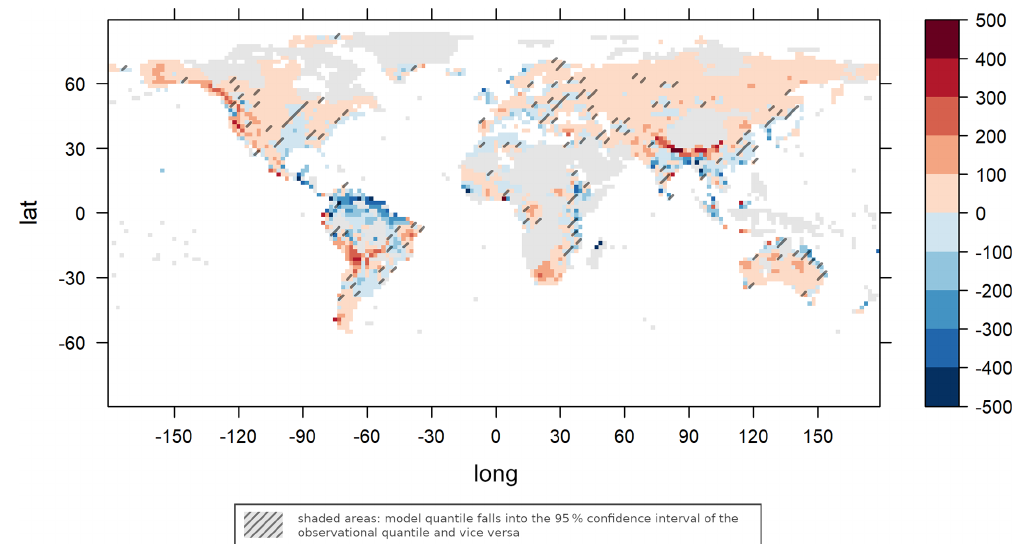
Figure 6. Difference between the 0 . 95 quantiles of the estimated GEV distribution for AWI-ESM model and observational data. Values exceeding the scale limits are truncated. Values are given in millimetres per month.